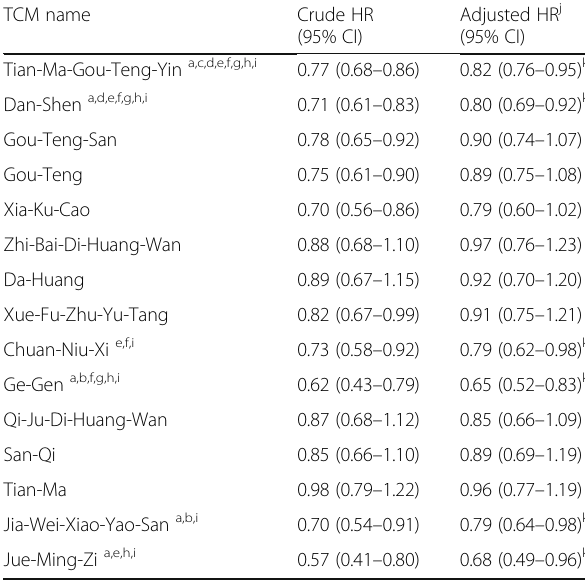
Table 5 Risk of dementia in relation to the top 15 commonly used